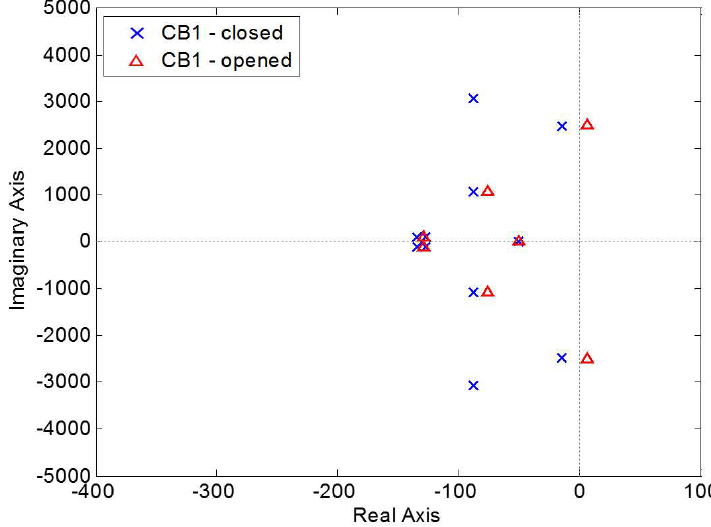
Figure 18. Poles of 1/ ( Y g + Y eq ) when CB1 is opened owing to converter malfunction.